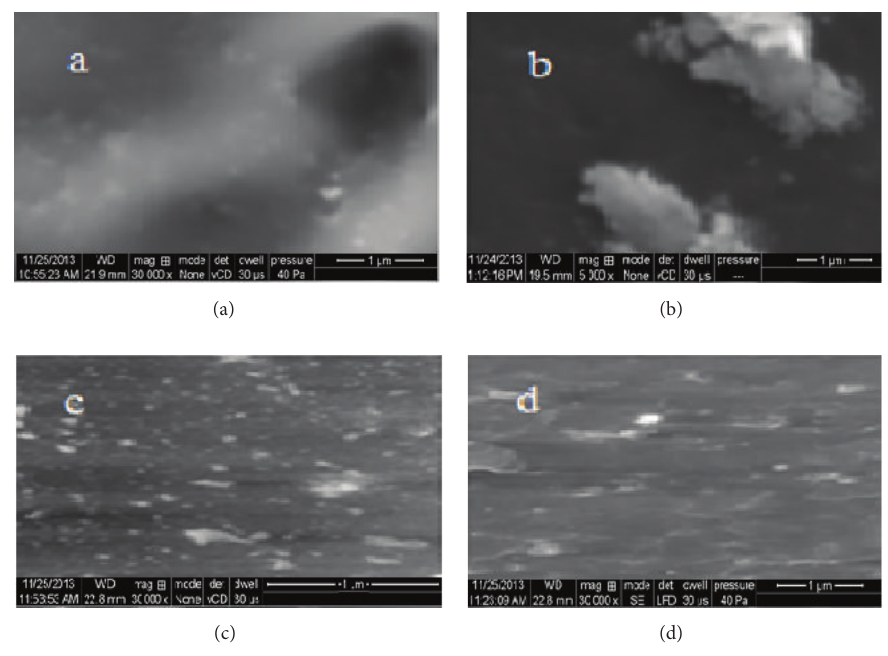
Figure 2: SEM Images of PU (a), CuPc(1%)/PU (b), CuPc(15%)/PU (c), and CuPc(30%)/PU (d),